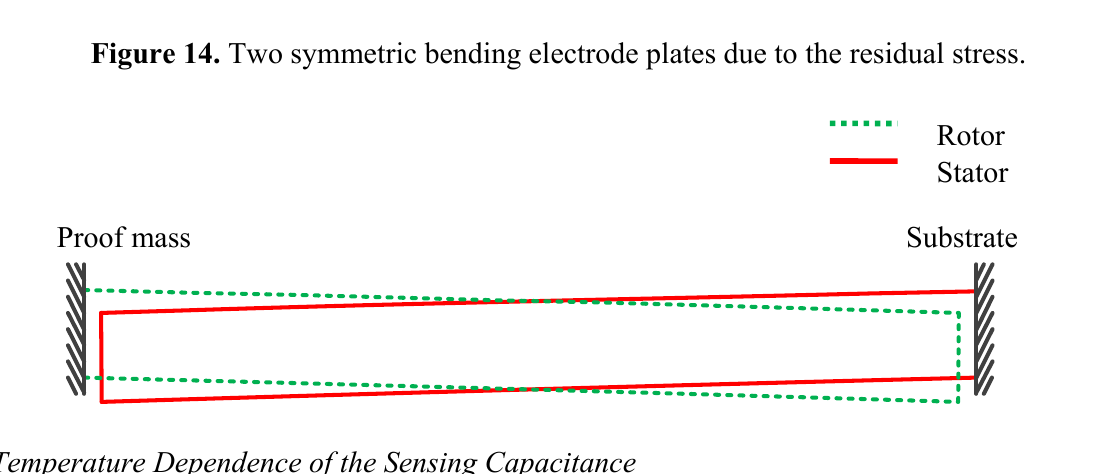
Figure 14. Two symmetric bending electrode plates due to the residual stress.